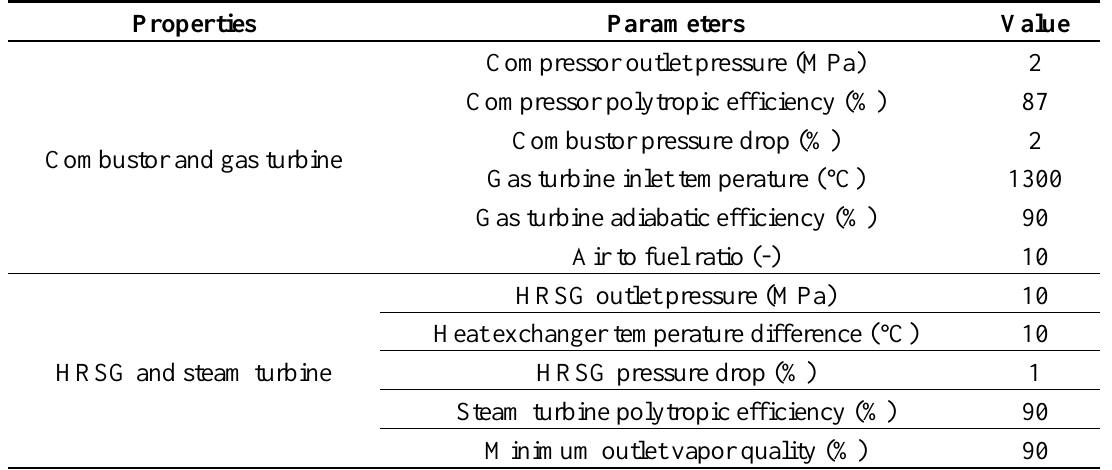
Table 4. Assumed conditions used during simulation for combined cycle including the gas and steam turbines. HRSG: heat recovery steam